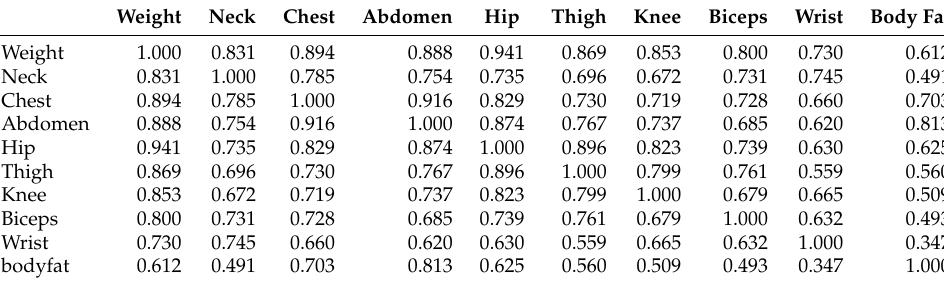
Table 14. Correlation matrix for Body Fat Prediction